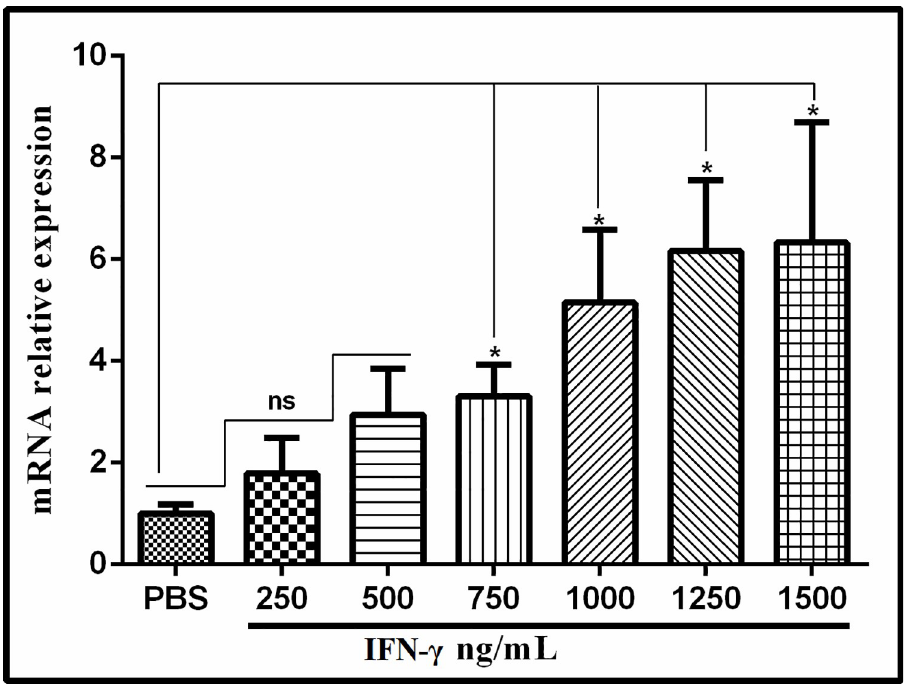
Fig 5. QRT-PCR analysis of Tsp-GILT expression during muscle larval stage treated with different concentration of IFN- γ and PBS (control). The significant level was set at � P < 0.05, and ns non-significant compared with control group.